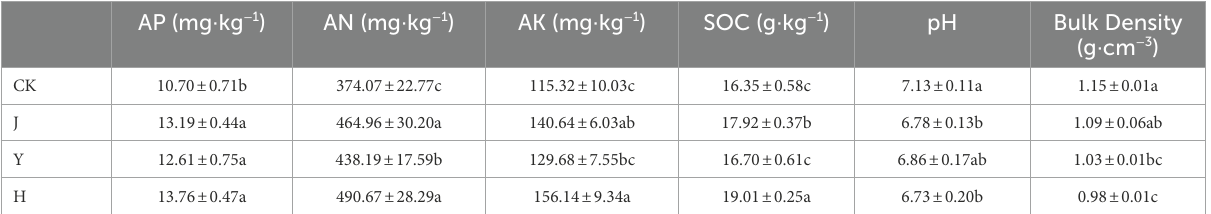
TABLE 8 Comparison of physicochemical properties of soybean potted soil after treatment with different